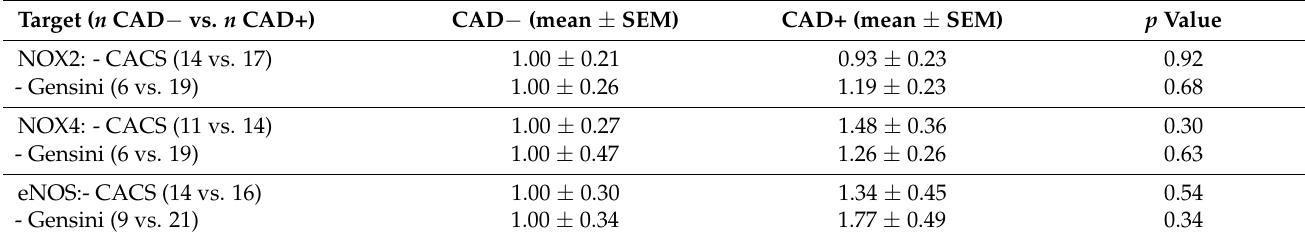
Table 2. ECFC Signalling Molecule Expression in Disease—CACS and the Gensini score. Target ( n CAD − vs. n